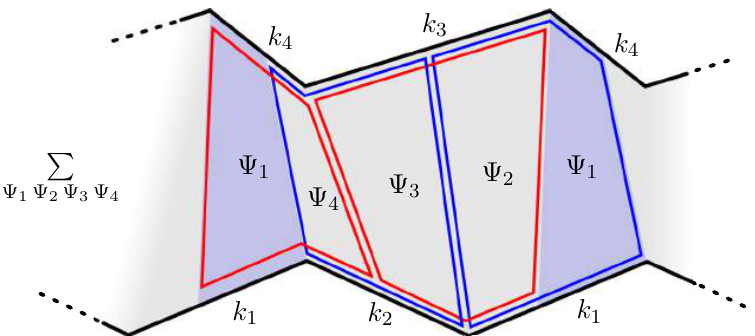
Figure 16 . The cylinder Wilson lines correlator can be computed at (cid:12)nite coupling using the pentagon operator product expansion. In this approach the correlator is decomposed into a sequence of GKP (cid:13)ux-tubes that correspond to the null squares in the (cid:12)gure. The quantum periodicity constraint is imposed by identifying the (cid:13)ux-tube state (cid:9) 1 in two channels that are related by the periodicity. This identi(cid:12)cation corresponds to cutting and gluing the holographic dual string in AdS 5 (cid:2) S 5